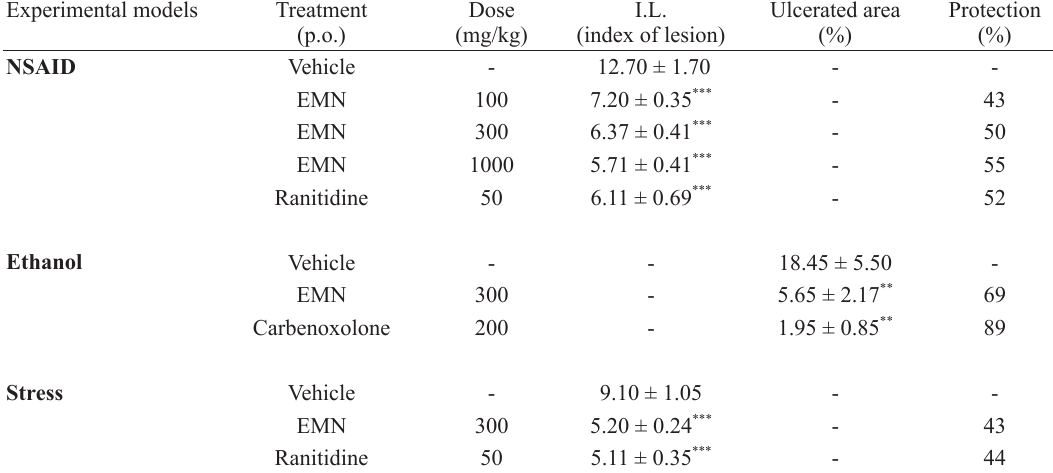
Effect of ethanolic root extract of Memora nodosa (EMN) in gastric ulcer models induced by NSAID, ethanol and stress in mice. Experimental